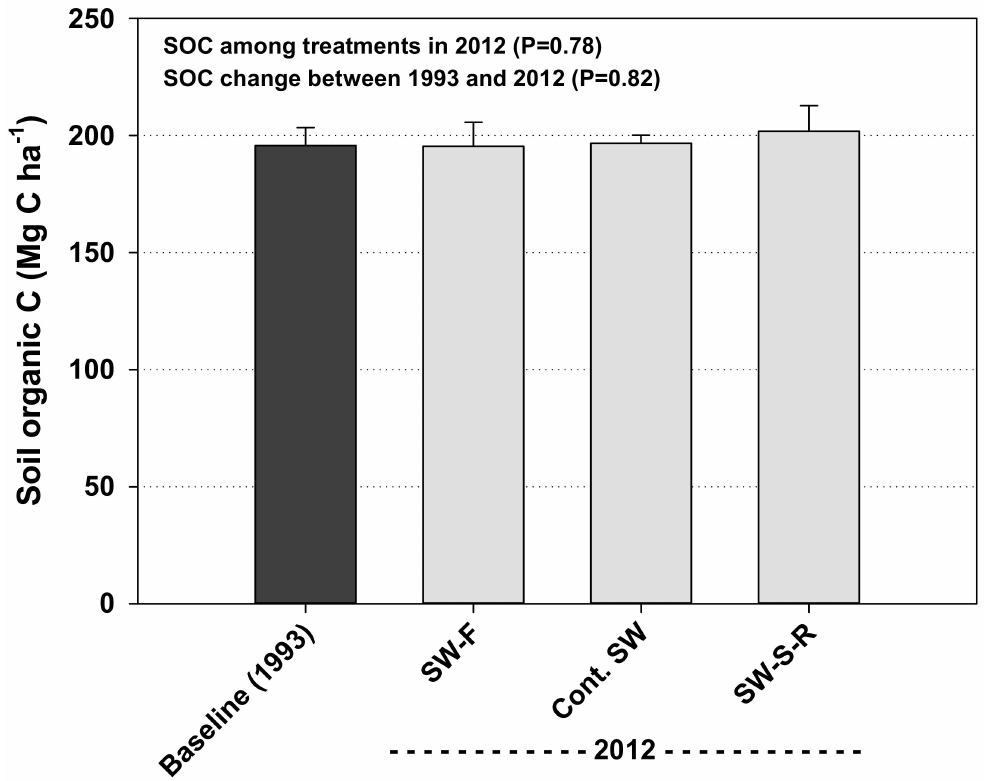
Figure 3. Soil organic carbon stocks in cropping system treatments in 1993 and 2012 using an equivalent soil mass of 18,885 Mg ha − 1 . Soil depth to reach equivalent mass was 1.37 m in 1993 and 1.27, 1.27 and 1.28 m in 2012 for spring wheat–fallow (SW-F), continuous spring wheat (Cont. SW) and spring wheat–safflower–rye (SW-S-R) cropping systems,